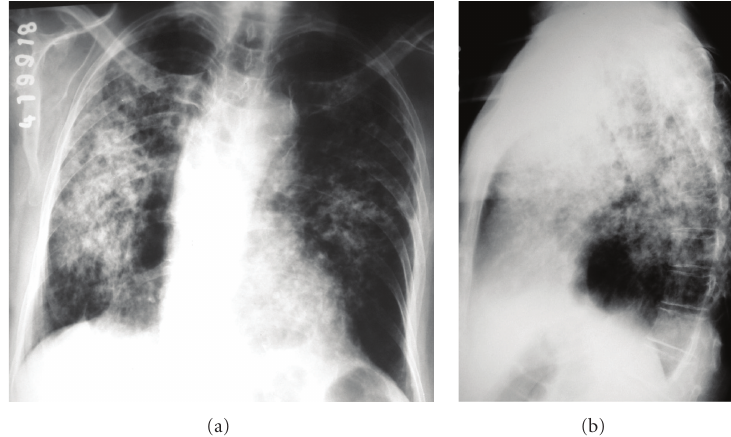
Figure 1: Chest radiographs in anteroposterior (a) and lateral incidence (b) showing hyperinflated lungs, with bilateral nonhomogeneous opacities, predominantly in the middle third of right lung.